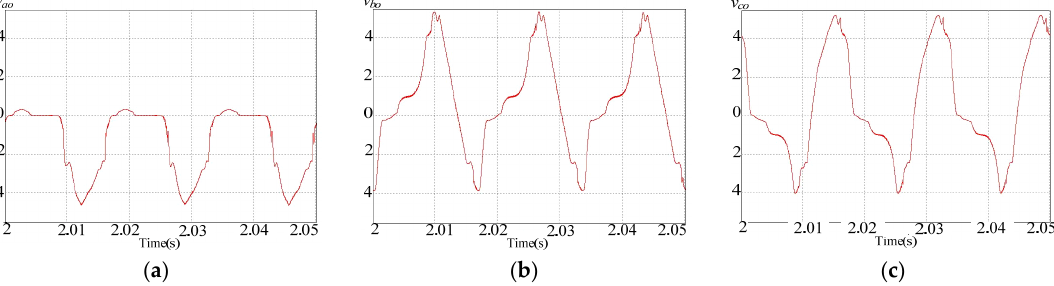
Figure 4. The output voltage waveform of three phases of inverter operating at 60 Hz and under conditions of faulty S a 1 + operation: ( a ) Phase voltage v ao ; ( b ) phase voltage v bo ; ( c ) phase voltage v co .